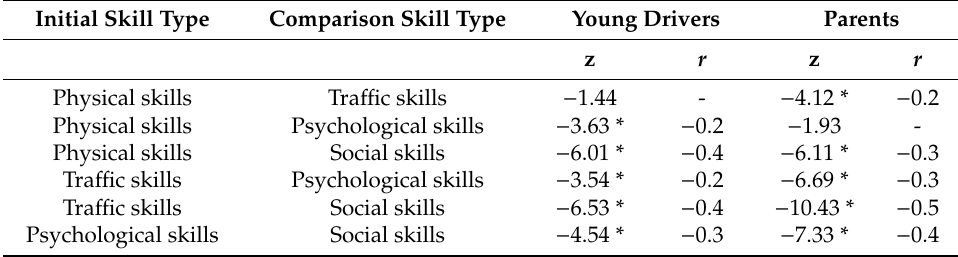
Table 2. Wilcoxon signed-rank tests comparing percentage amounts assigned by young drivers and parents to skill types that could be trained with